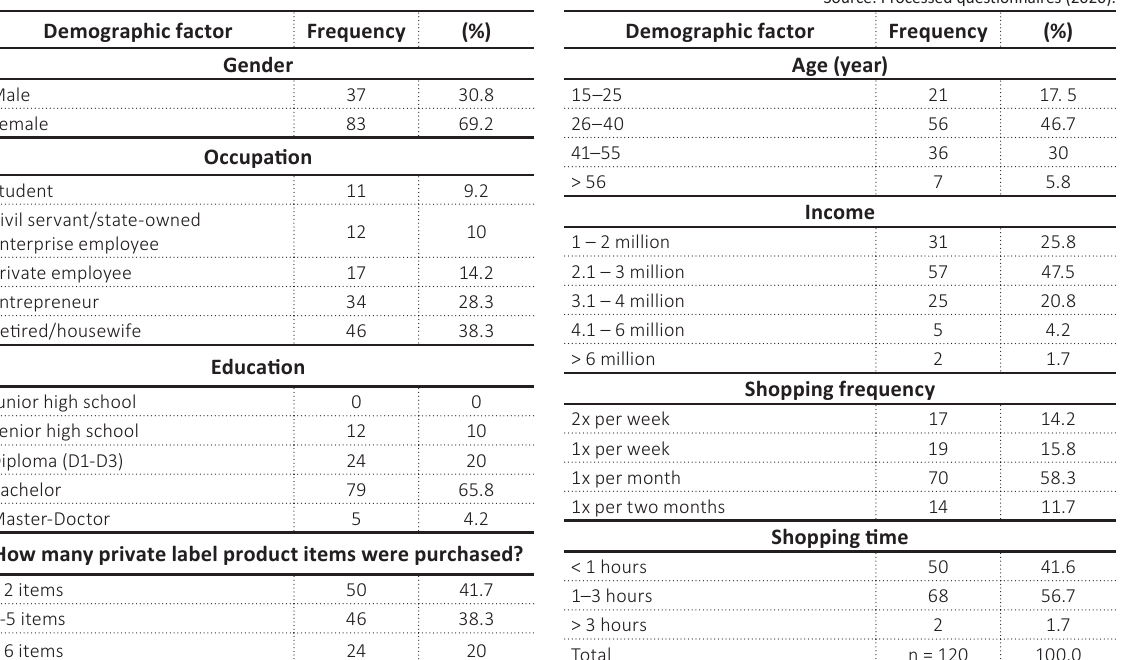
Table 3. The measurement model evaluation